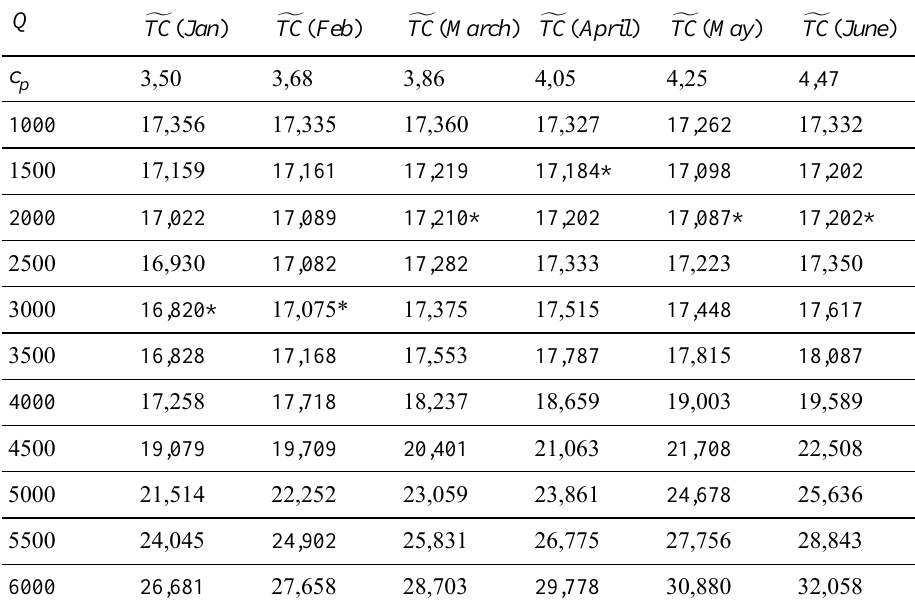
Table 5. Fuzzy total cost for pre-season ordering periods,